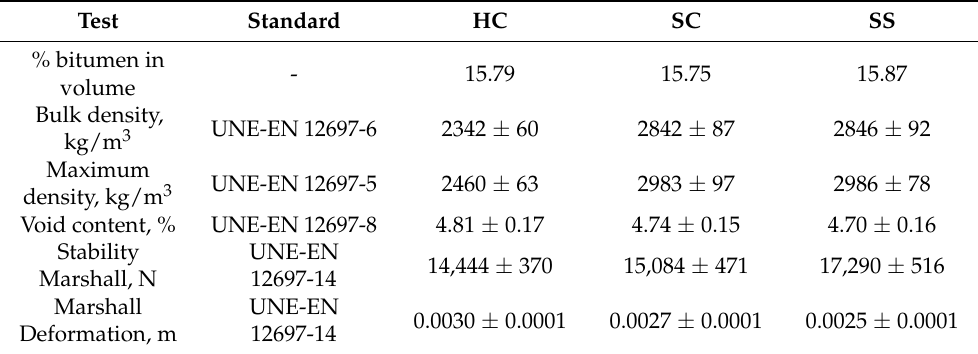
Table 11. Results of the tests for the optimum combination of materials from the HC, SC, and SS families of bituminous